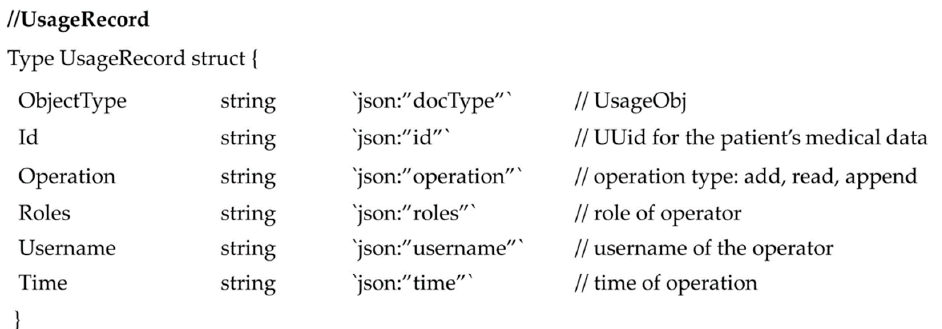
Figure 6. Data type of usageRecord.